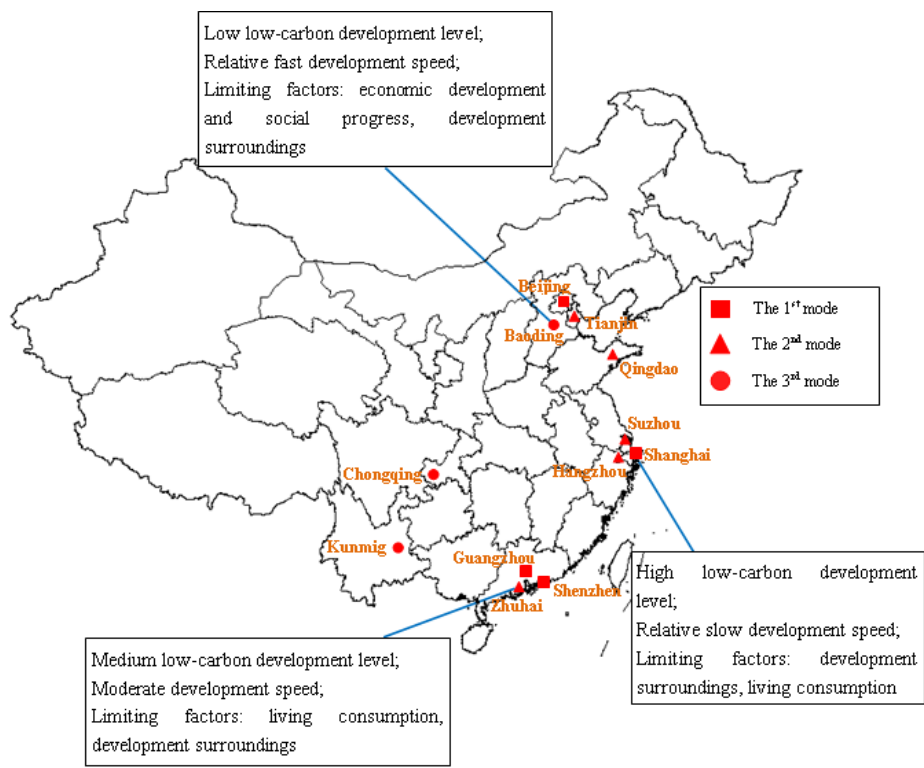
Figure 5. Low-carbon development patterns of 12